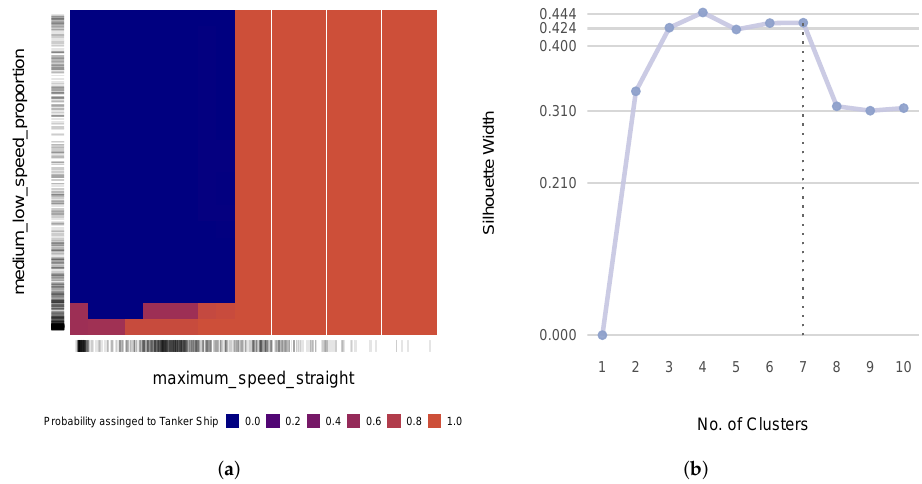
Figure 10. ( a ) The PDP of maximum_speed_straight and medium_low_speed_proportion for the kinematic descriptor-based model; ( b ) the silhouette scores from the different numbers of clusters for the hybrid